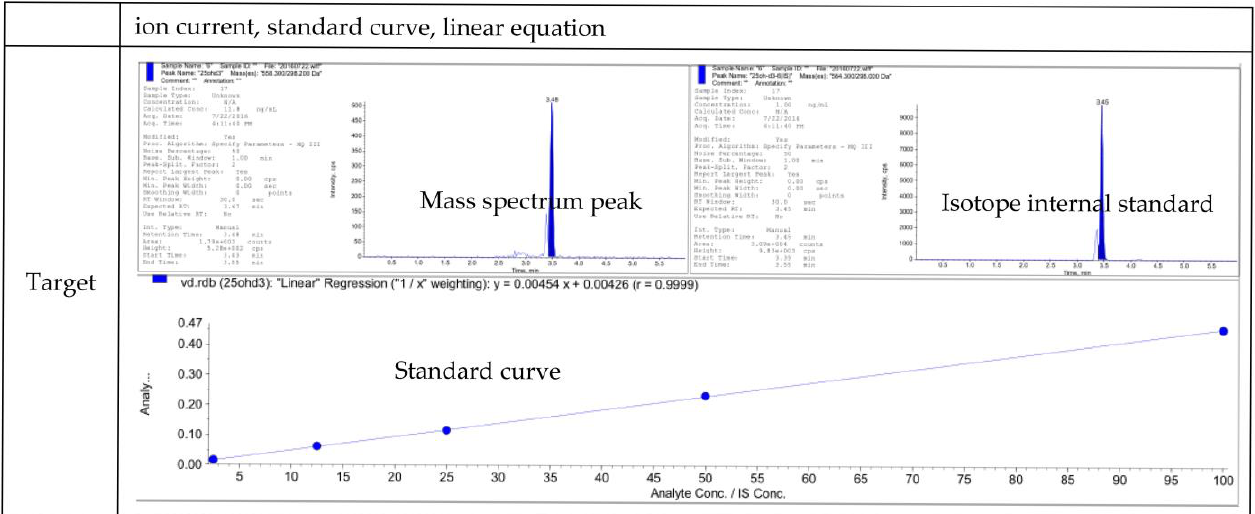
Figure 1. Quality control of the assessment of vitamin D status.